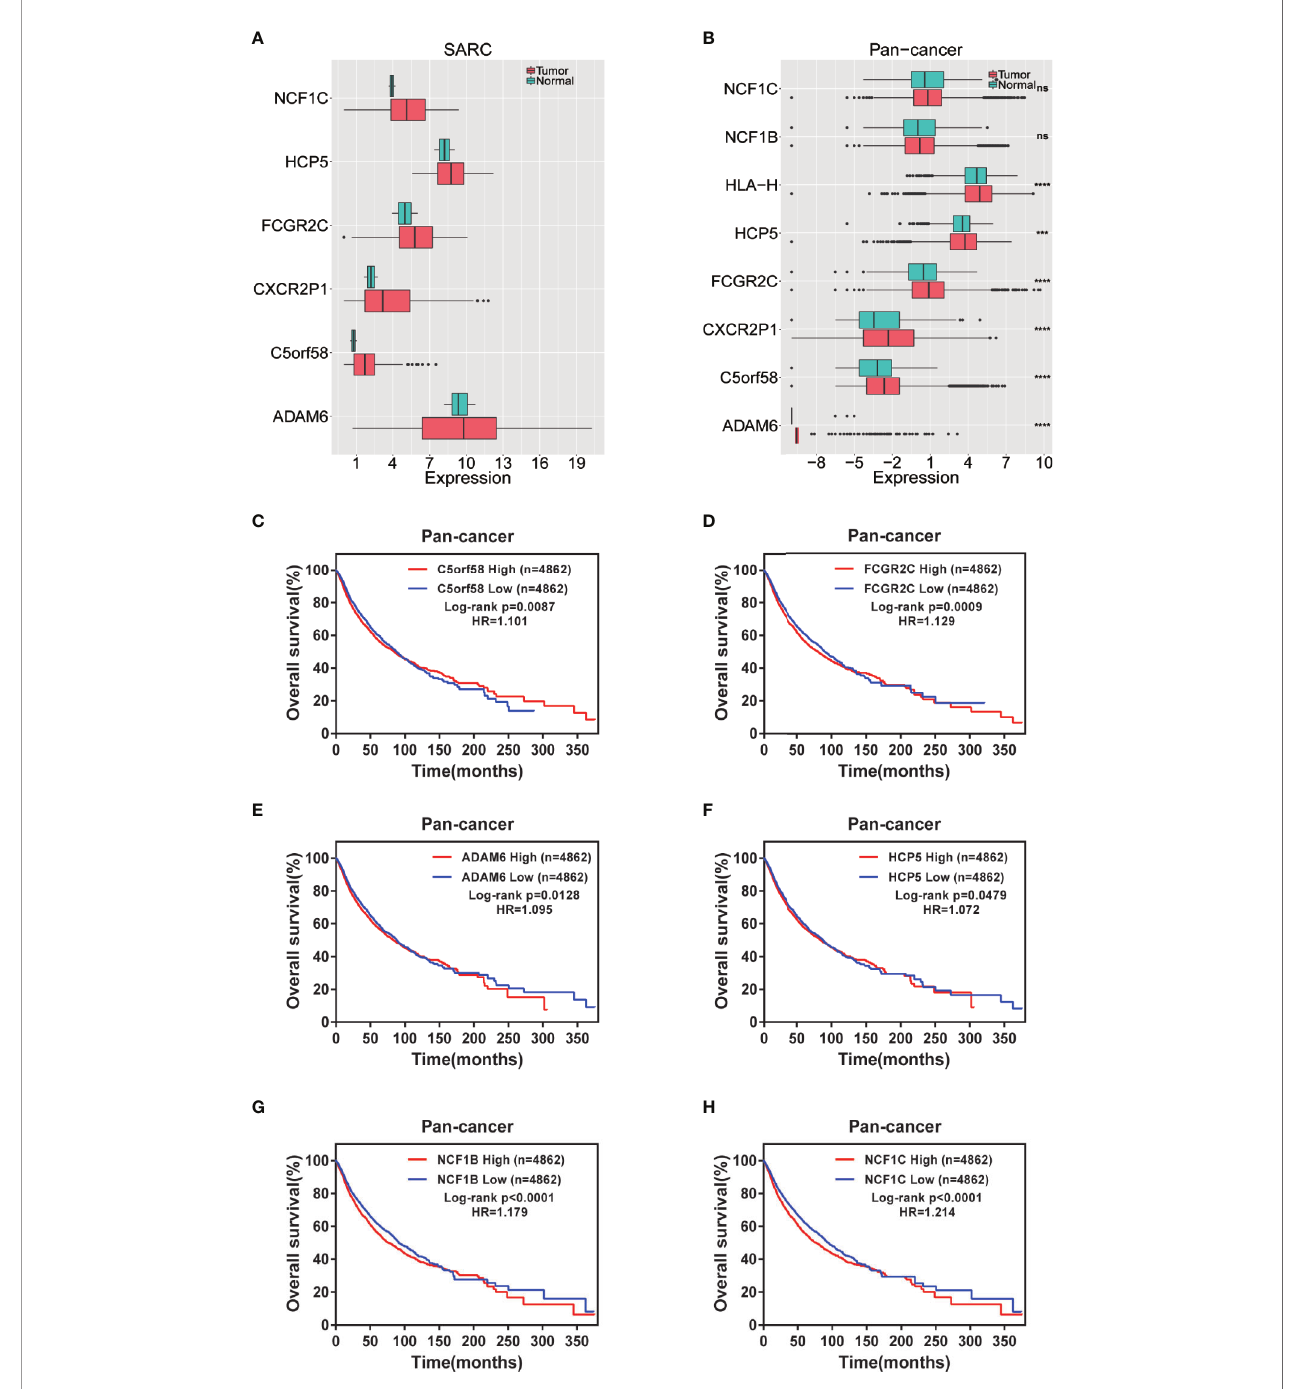
FIGURE 4 | Expression of ICLs and prognosis in human cancer. (A) Expression of ICLs in sarcoma. (B) Expression of ICLs in pancancer. (C – H) Expression of C5orf58/ FCGR2C/ADAM6/NCF1B/NCF1C and overall survival across cancers. (D) Expression of ICLs and overall survival in pancancer. ***P < 0.001; ****P < 0.0001; NS, No signi fi